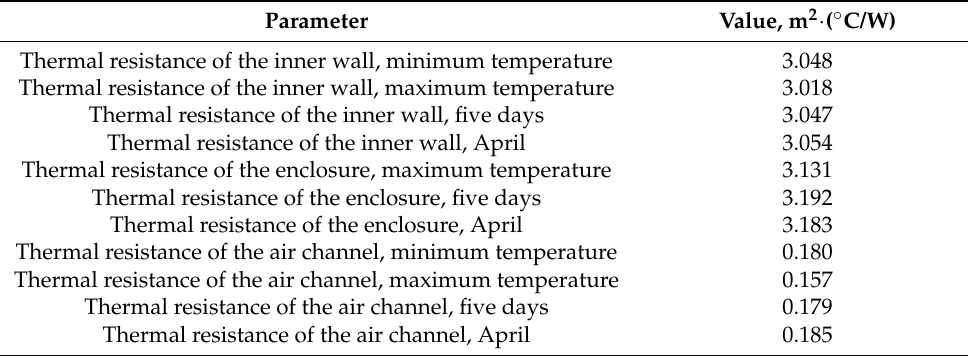
Table 9. Thermal resistance of the enclosure according to Figure